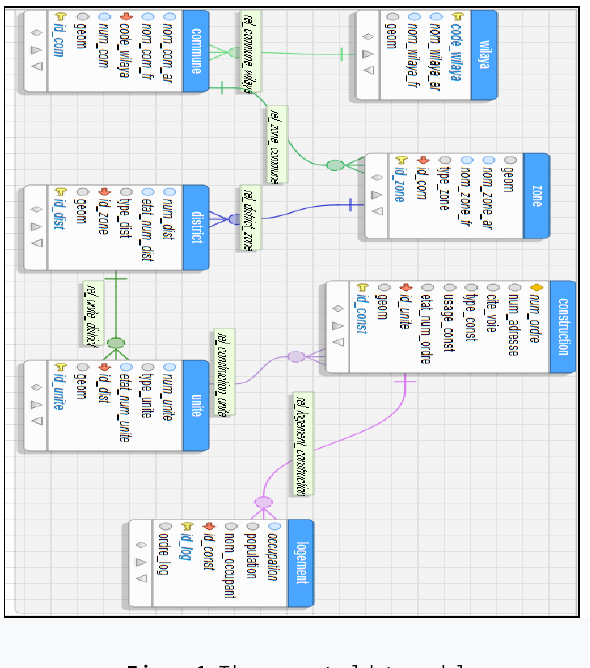
Figure 1 . The conceptual data model